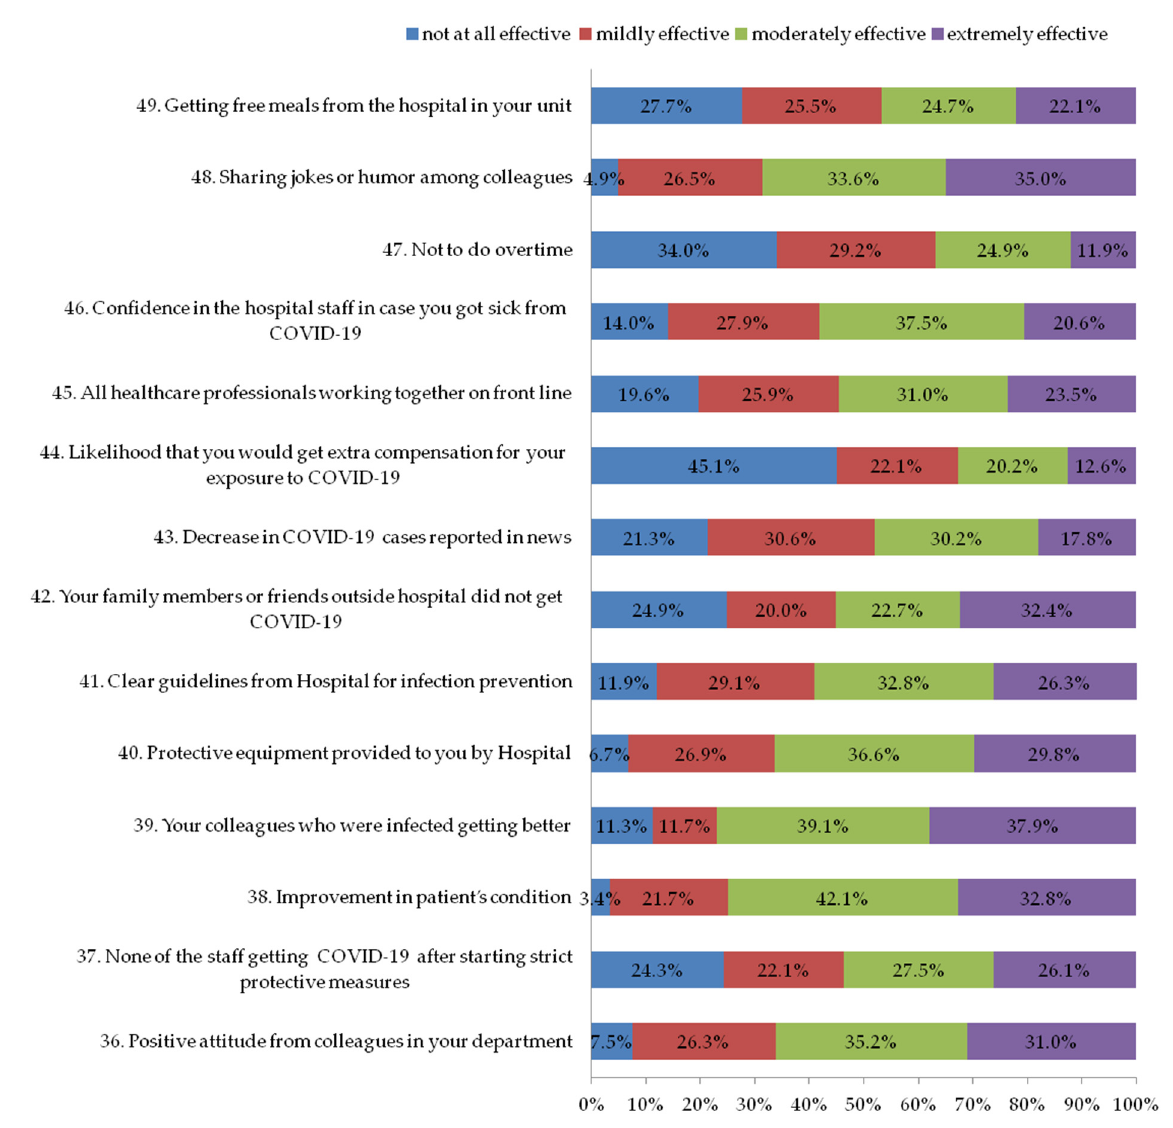
Figure 3. Factors that helped to reduce stress during COVID-19 outbreak.